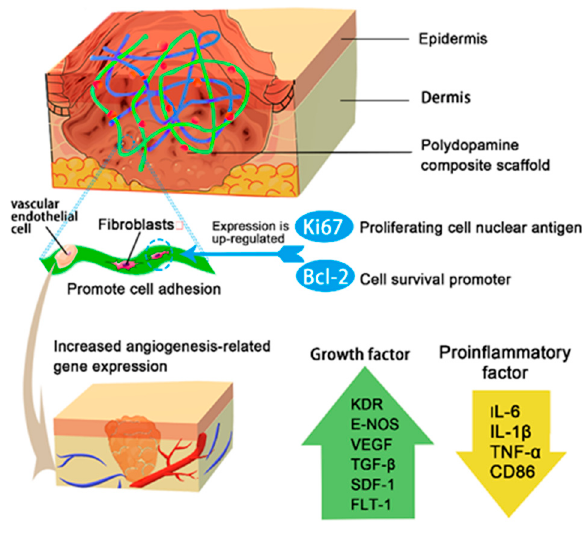
Figure 5. Regulation of wound tissue differentiation by PDA dressing.